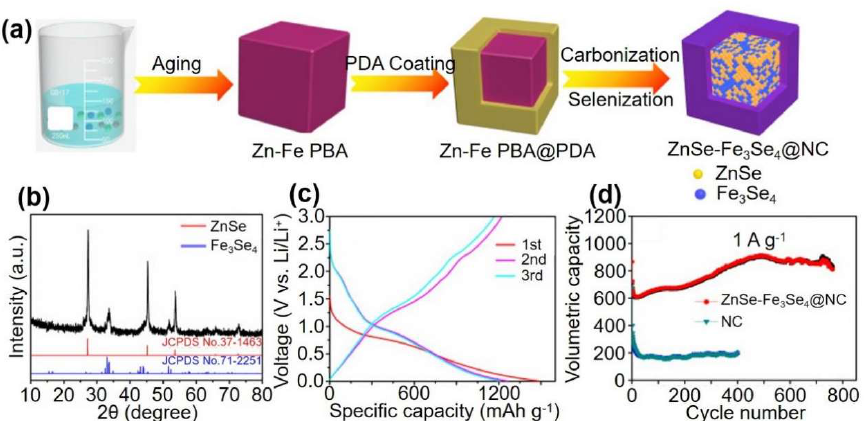
Figure 5. ( a ) Schematic diagram of synthesis process of the ZnSe-Fe 3 Se 4 @NC. ( b ) XRD pattern of ZnSe-Fe 3 Se 4 @NC. ( c ) Discharge and charge profiles of ZnSe-Fe 3 Se 4 @NC anode. ( d ) Long cycling performance of ZnSe-Fe 3 Se 4 @NC and NC anodes at 1 A g − 1 . Ref. [18] Copyright Journal of Alloys and Compounds, Elsevier.